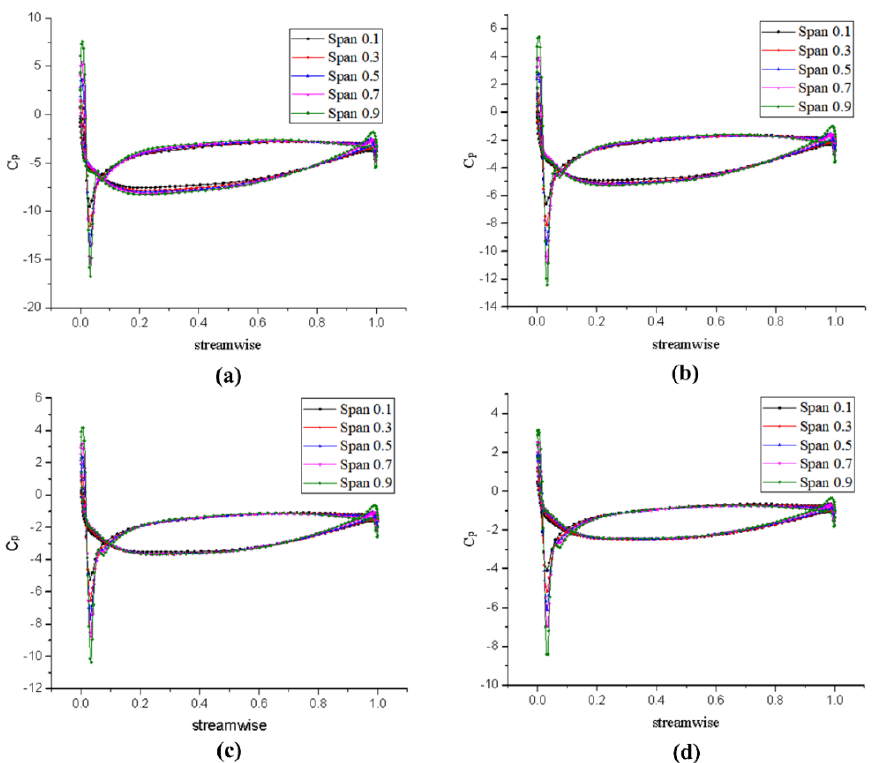
Figure 31. Tangential pressure distribution of rotor designed by inverse design method: ( a ) v = 7 m/s ( J = 0.78), ( b ) v = 8.5 m/s ( J = 0.95), ( c ) v = 10 m/s ( J = 1.12), and ( d ) v = 11.5 m/s ( J = 1.28).